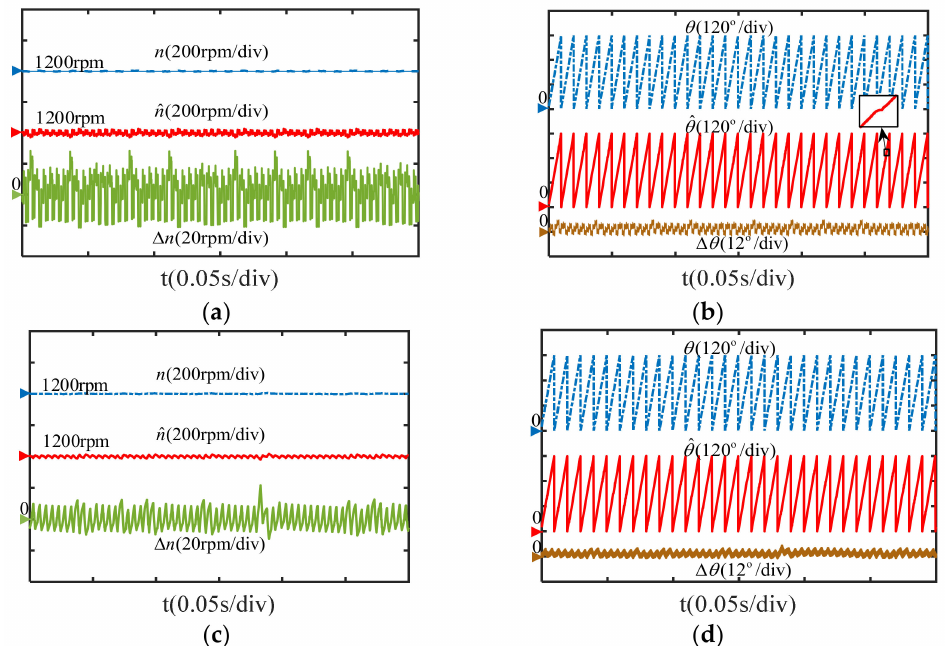
Figure 11. ( a ) Speed waveforms of Luenberger observer; ( b ) Position waveforms of Luenberger observer; ( c ) Speed waveforms of the dual observer; ( d ) Position waveforms of the dual observer.